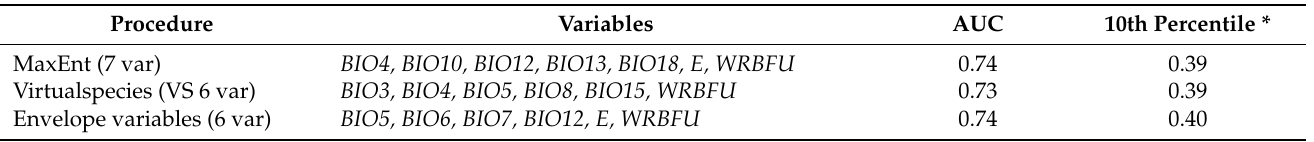
Table 5. Explanatory variables selection by procedure: (1) MaxEnt software selection module; (2) Virtualspecies R package; and (3) Ecological envelope